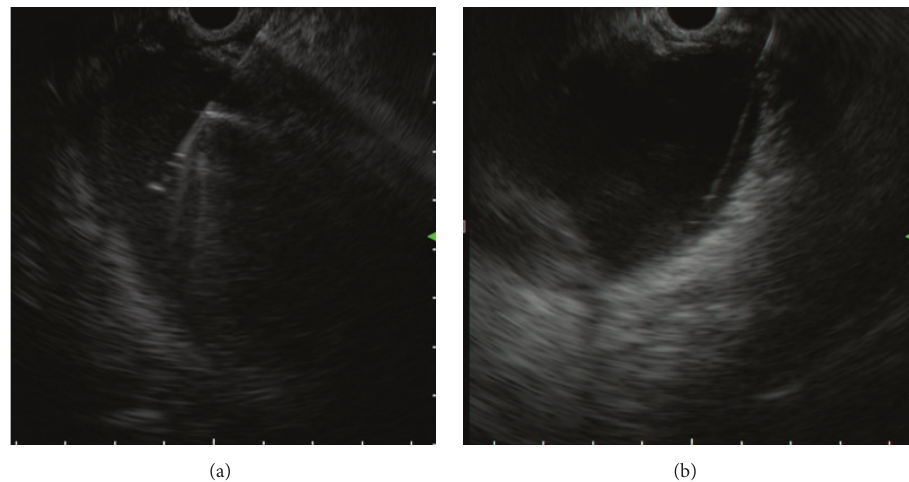
Figure 1: Endoscopicultrasound(EUS) images. (a)EUS-guided punctureof a complicated cyst with a 19-gauge fineneedle, and (b)placement of a 0.035-inch guidewire into the